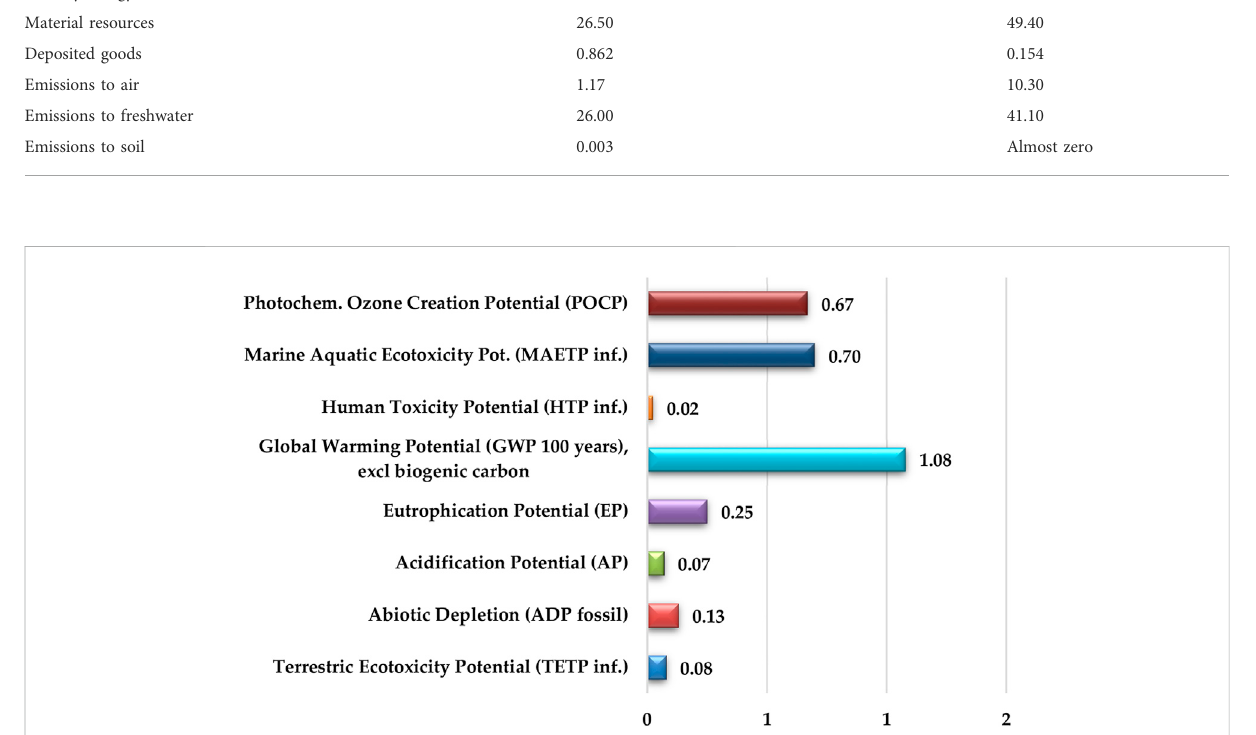
FIGURE 1 Normalized and weighted values of the environmental impact categories for land fi ll in nanograms. Functional unit: 1 kg of municipal solid waste, EU-28. Normalization method: CML 2016, EU 25 + 3, year 2000, excl. biogenic carbon. Weighting method: thinkstep LCIA Survey 2012, Europe, CML 2016, excl. biogenic carbon. (Source: own analyzes with GaBi 8.0